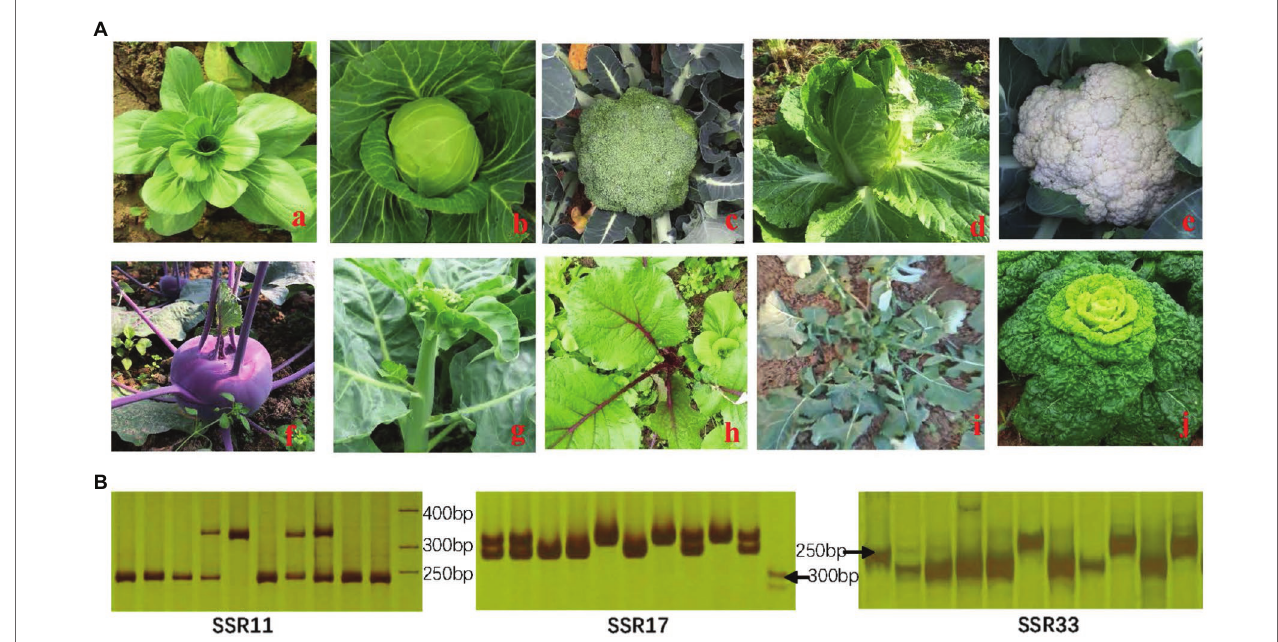
FIGURE 9 | Identification of related species in the Brassicaceae family (A) and amplified results by SSR primers (B) . (a) Brassica campestris subsp. chinensis (AA); (b) Brassica oleracea var. capitata (CC); (c) B. oleracea var. italica (CC); (d) Brassica rapa ssp. pekinensis (AA); (e) B. oleracea var. botrytis (CC); (f) B. oleracea var. caulorapa ; (g) B. alboglabra ; (h) B. parachinensis ; (i) B. napus (AACC); (j) B. campestris L. ssp.